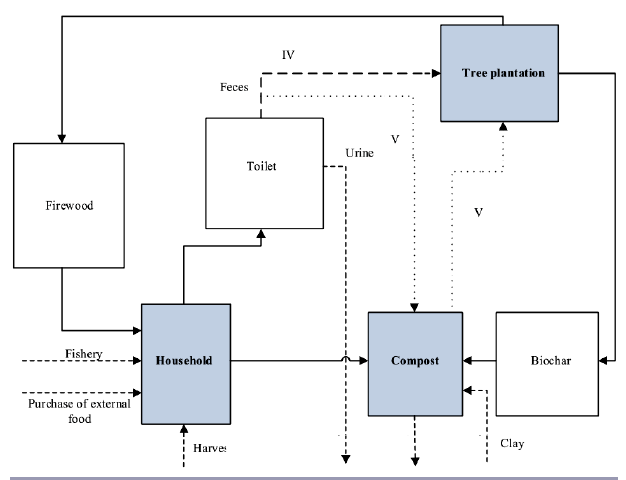
Fig. 4 . Scenario IV and V: In these scenarios a tree plantation is integrated in order to produce firewood and coal, which allow independence from external wood resources. Therefore, only the fishery and purchase of external food integrate external nutrients into the system. In scenario IV, feces are used as nutrient input for the tree plantation (dashed line). In constrast, scenario V includes feces only in the compost, and the tree plantation is fertilized by a certain portion of it (dotted line).